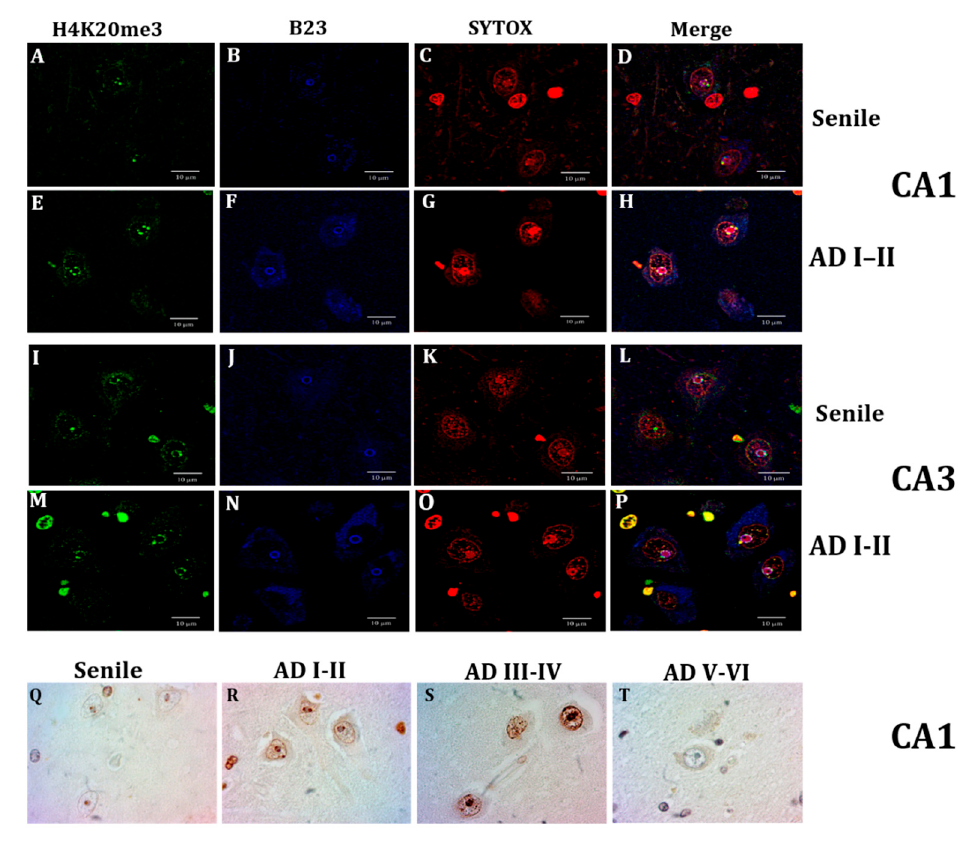
Figure 6. Confocal analysis of H4K20me3 (green), and nucleoli immunofluorescence through nucleophosmin antibody (B23, blue) and nucleic acids through SYTOX (red). Neurons from a senile subject present in CA1 ( A ) and CA3 ( I ) scarce positive green marks, and well-delimited nucleoli ( B , J ), and the epigenetic H4K20me3 marks localized in the nucleolar chromatin ( C , D , K , L ). A marked increase of nuclear speckles and spots around the nucleoli and adjacent to the nuclear lamina is observed at AD (I-II) ( E , M ) and B23 immunofluorescence is not limited to the nucleoli but also dispersed in the cytoplasm ( F , N , H , P ), and H4K20me3 marks are not only in the nucleolar chromatin ( G , O ) but also adjacent to the nuclear lamina ( H , P ). H4K20me3 immunostaining. Distribution of H4K20me3 immunopositivity around the nucleolus (NADs) and adjacent to the nuclear lamina (LADs) ( Q ). Intensely marked nuclei at AD I-II stages ( R ) and AD II-IV stages ( S ) and null to slight positivity at late AD stages ( T , L ), scale bar—10 µm.